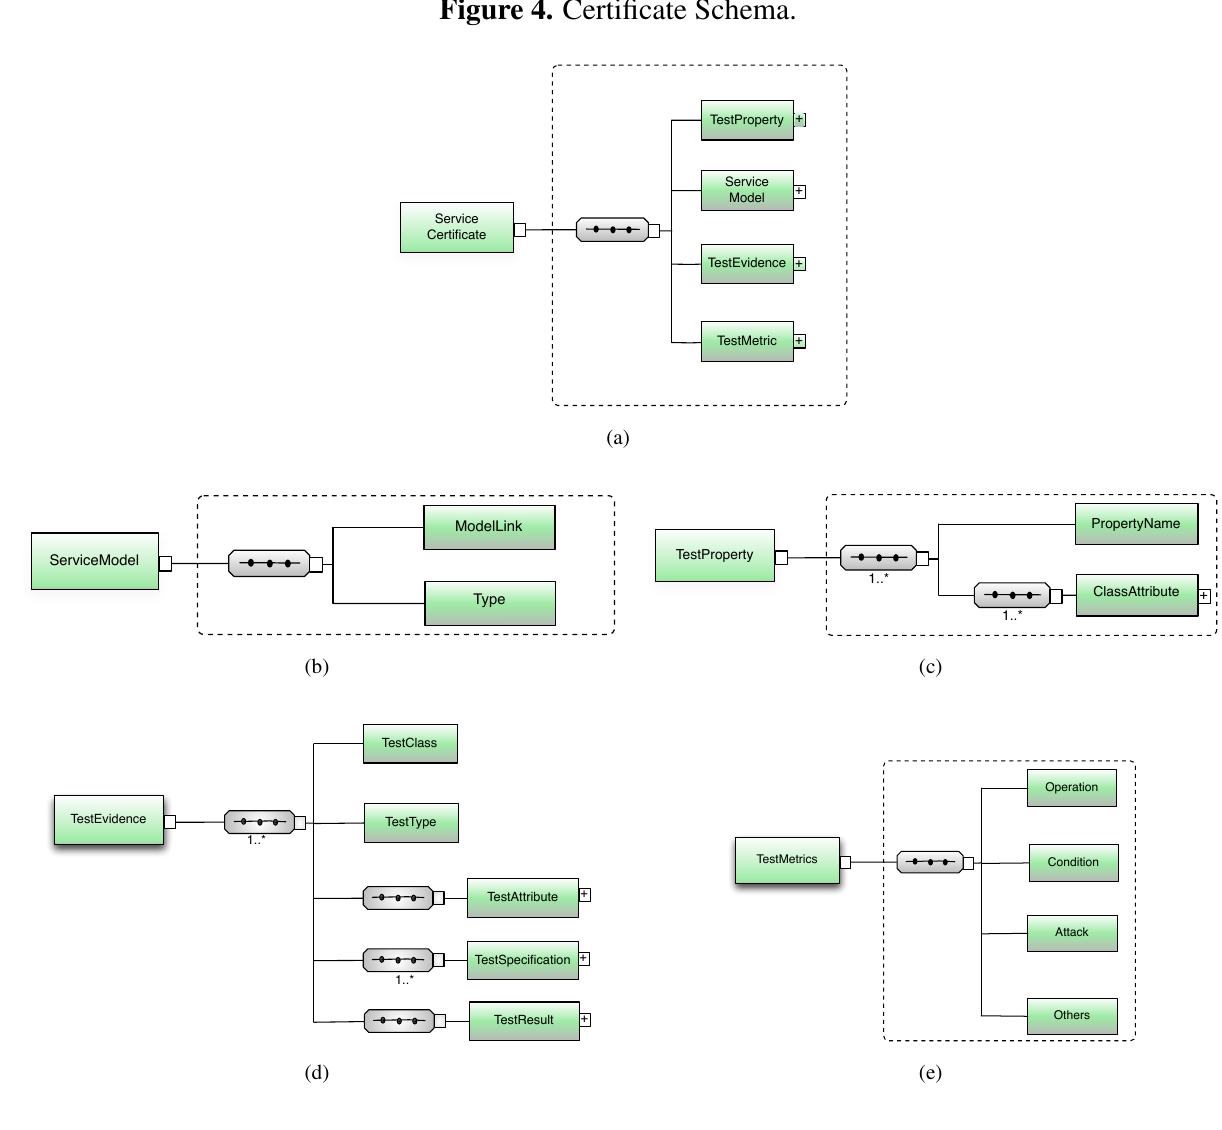
Figure 4. Certificate